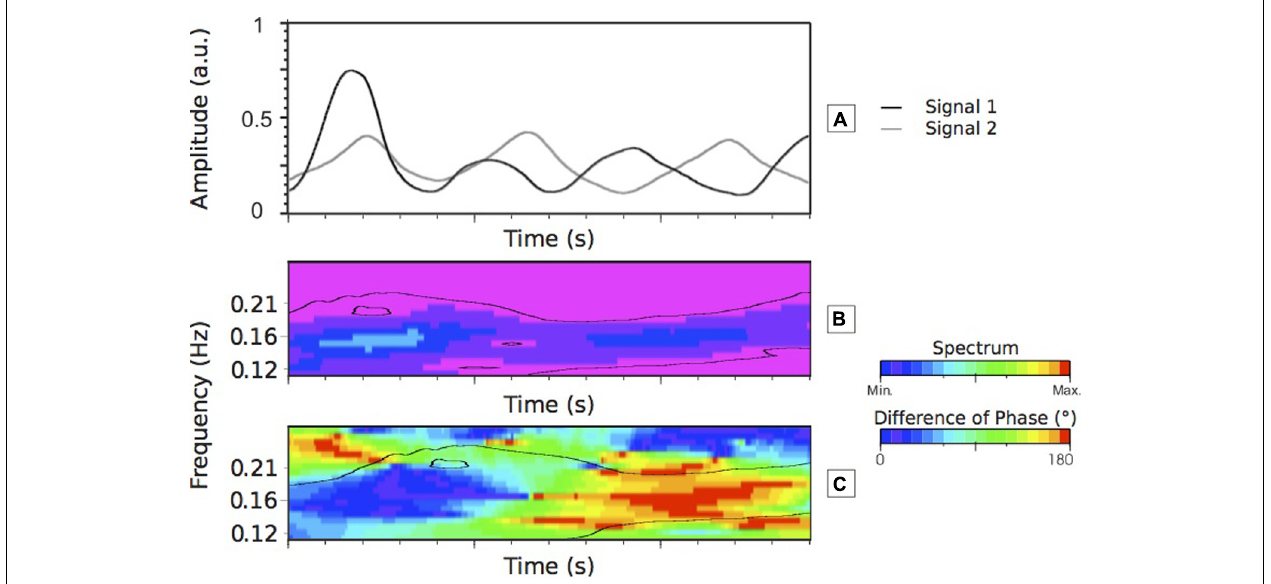
spectrum value occurs at the beginning of (B) .This is mainly explained by the high amplitude (i.e., intensity) of Signal 1.Visually one can estimate the common frequency of the two signals around a value of 0.16 Hz. (C) Shows the RP between Signals 1 and 2. (C) Confirms the visual description of (A) where for the first part of the time-series, the two signals are closed to a phase pattern drifting to an anti-phase pattern toward the end of the time-series.The range of colors facilitates the visualization of the associated RP from in-phase (close to 0 ◦ ) to anti-phase (close to 180 ◦ ). a.u., arbitrary